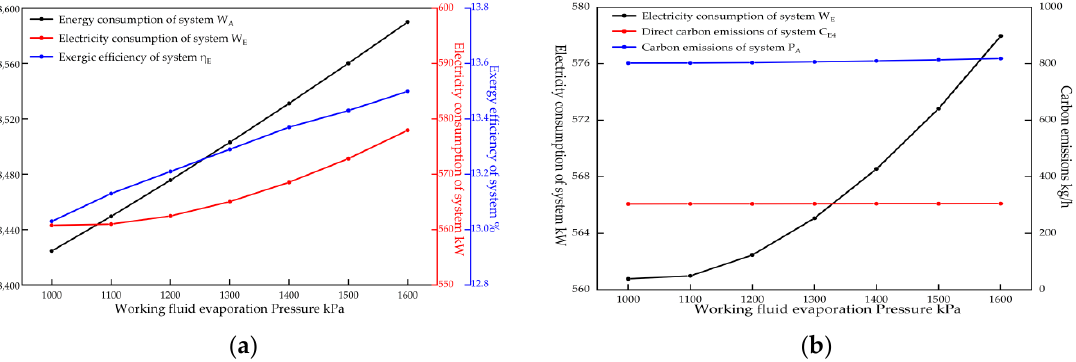
Figure 6. The effect of evaporation pressure of working fluid on system performance. ( a ): System energy consumption and exergy efficiency; ( b ): System electricity consumption and carbon emissions.